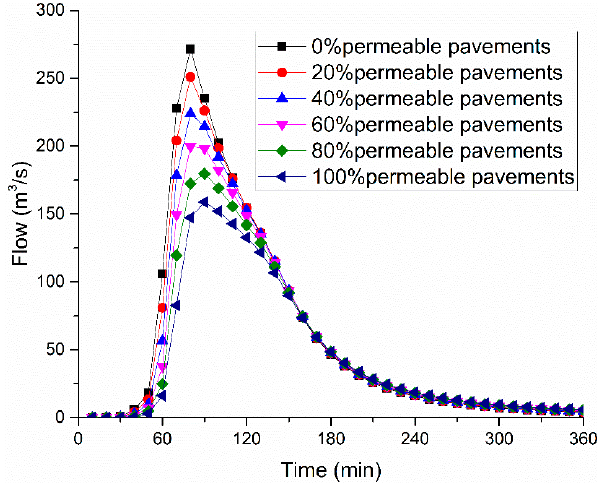
Figure 11. Outlet flow with different proportions of permeable pavements (P = 10 rainfall).